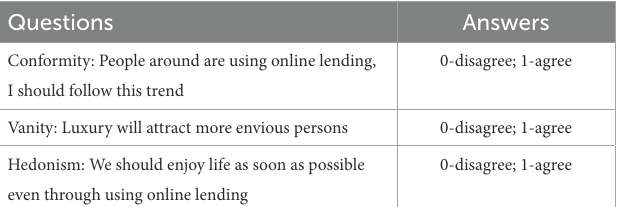
TABLE 2 The survey questions of three central psychology causing online lending based on